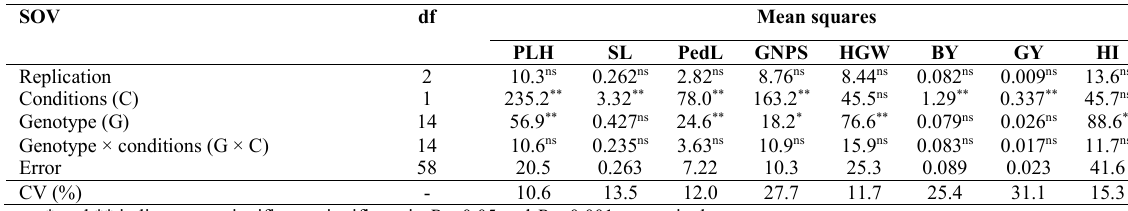
Table 3. Analysis of variance for studied traits of durum wheat genotypes as the factorial experiment based on randomized complete block design. Source of variation (SOV), degree of freedom (df), coefficient of variations (CV), plant height (PLH), spike length (SL), peduncle length (PedL), grains number per spike (GNPS), 1000-grain weight (HGW), biomass yield (BY), grain yield (GY), and harvest index (HI).